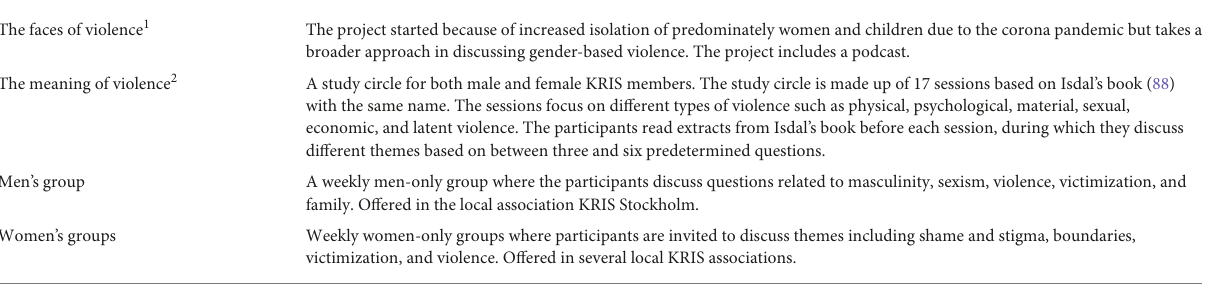
TABLE 1 KRIS projects. The faces of violence